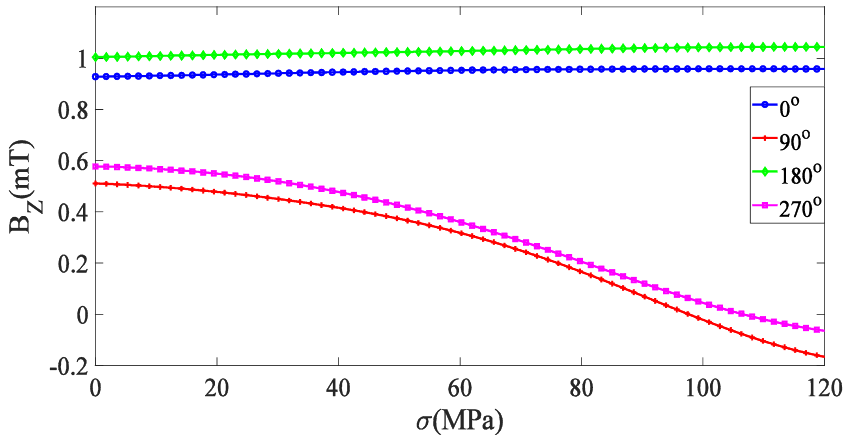
Figure 7. Changes in magnetic signals of B Z relative to stress σ at angles of 0°, 90°, 180°, and